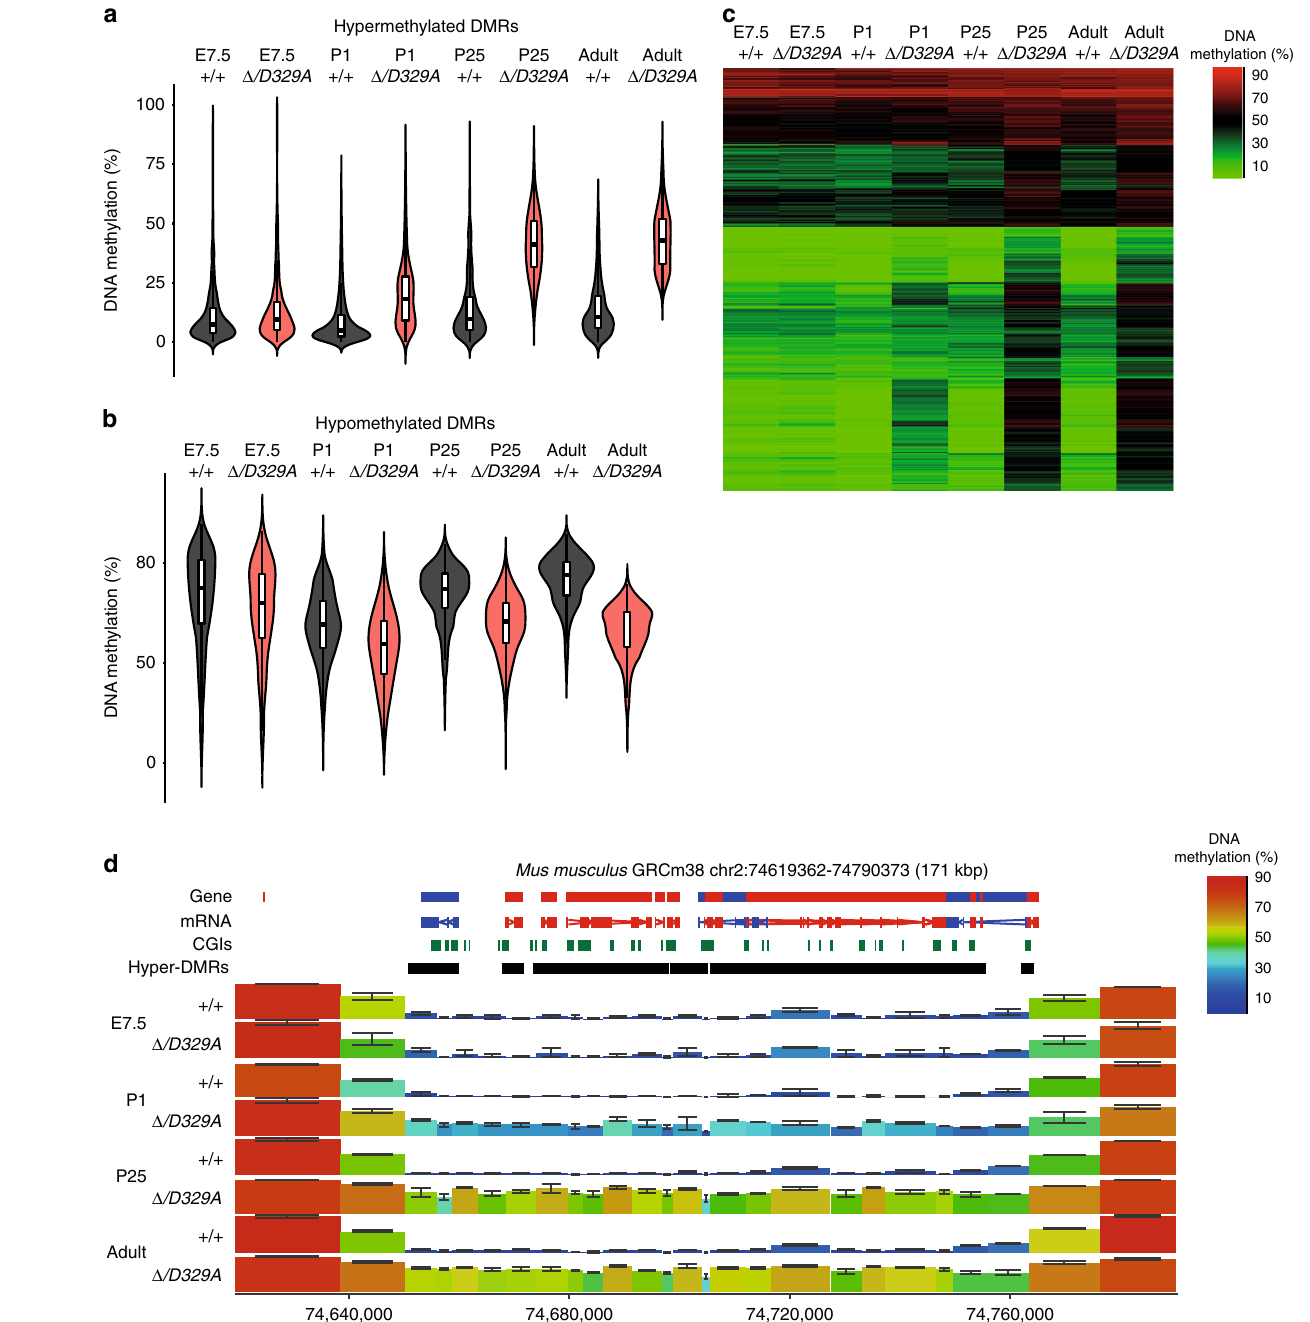
Fig. 4 DNA methylation dynamics during development. a , b Beanplots indicating DNA methylation levels over hyper-methylated ( a ) and hypo-methylated ( b ) DMRs across development in Dnmt3a + / + and Dnmt3a Δ /D329A mice. Tiles were quanti fi ed over adult hypothalamus DMRs, which were merged if the distance was <1 kb. Boxplots show median value and 25 – 75th percentiles, whiskers show lowest and highest observation, excluding outliers. Raw data are provided in Source Data. c Heatmap showing how methylation is gained at DMRs over time. Shown are 1915 300-CpG tiles, overlapping DMRs identi fi ed between Dnmt3a + / + and Dnmt3a Δ /D329A in adult (14-week) hypothalamus. DMRs are clustered based on Euclidean method, on the basis of smallest absolute difference between quantitation values. Tiles of 300-CpGs. d Genome browser view of the Hoxd gene cluster indicating progressive gain in DNA methylation across the whole domain. For gene and mRNA tracks, the colour indicates direction, where red is a forward strand and blue is a reverse strand. CGI: CpG island, hyper-DMR: hypermethylated region identi fi ed in adult hypothalamus. Colour-coded blocks indicate tiles of 300-CpG positions. Error bars indicate standard deviation. In a – d , E7.5 is epiblast, and P1, P25 and adult are hypothalamus. n (E7.5) = 4, n (P1, P25) = 2, n (adult) =